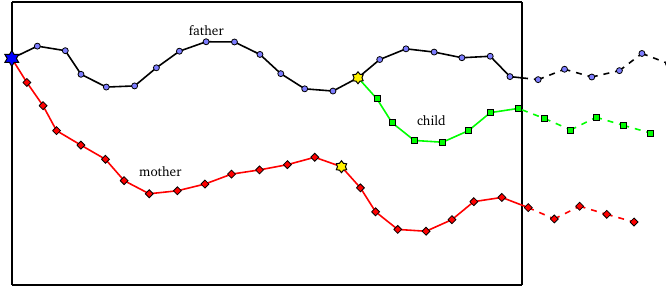
Figure 6. Illustration of the crossover operator of